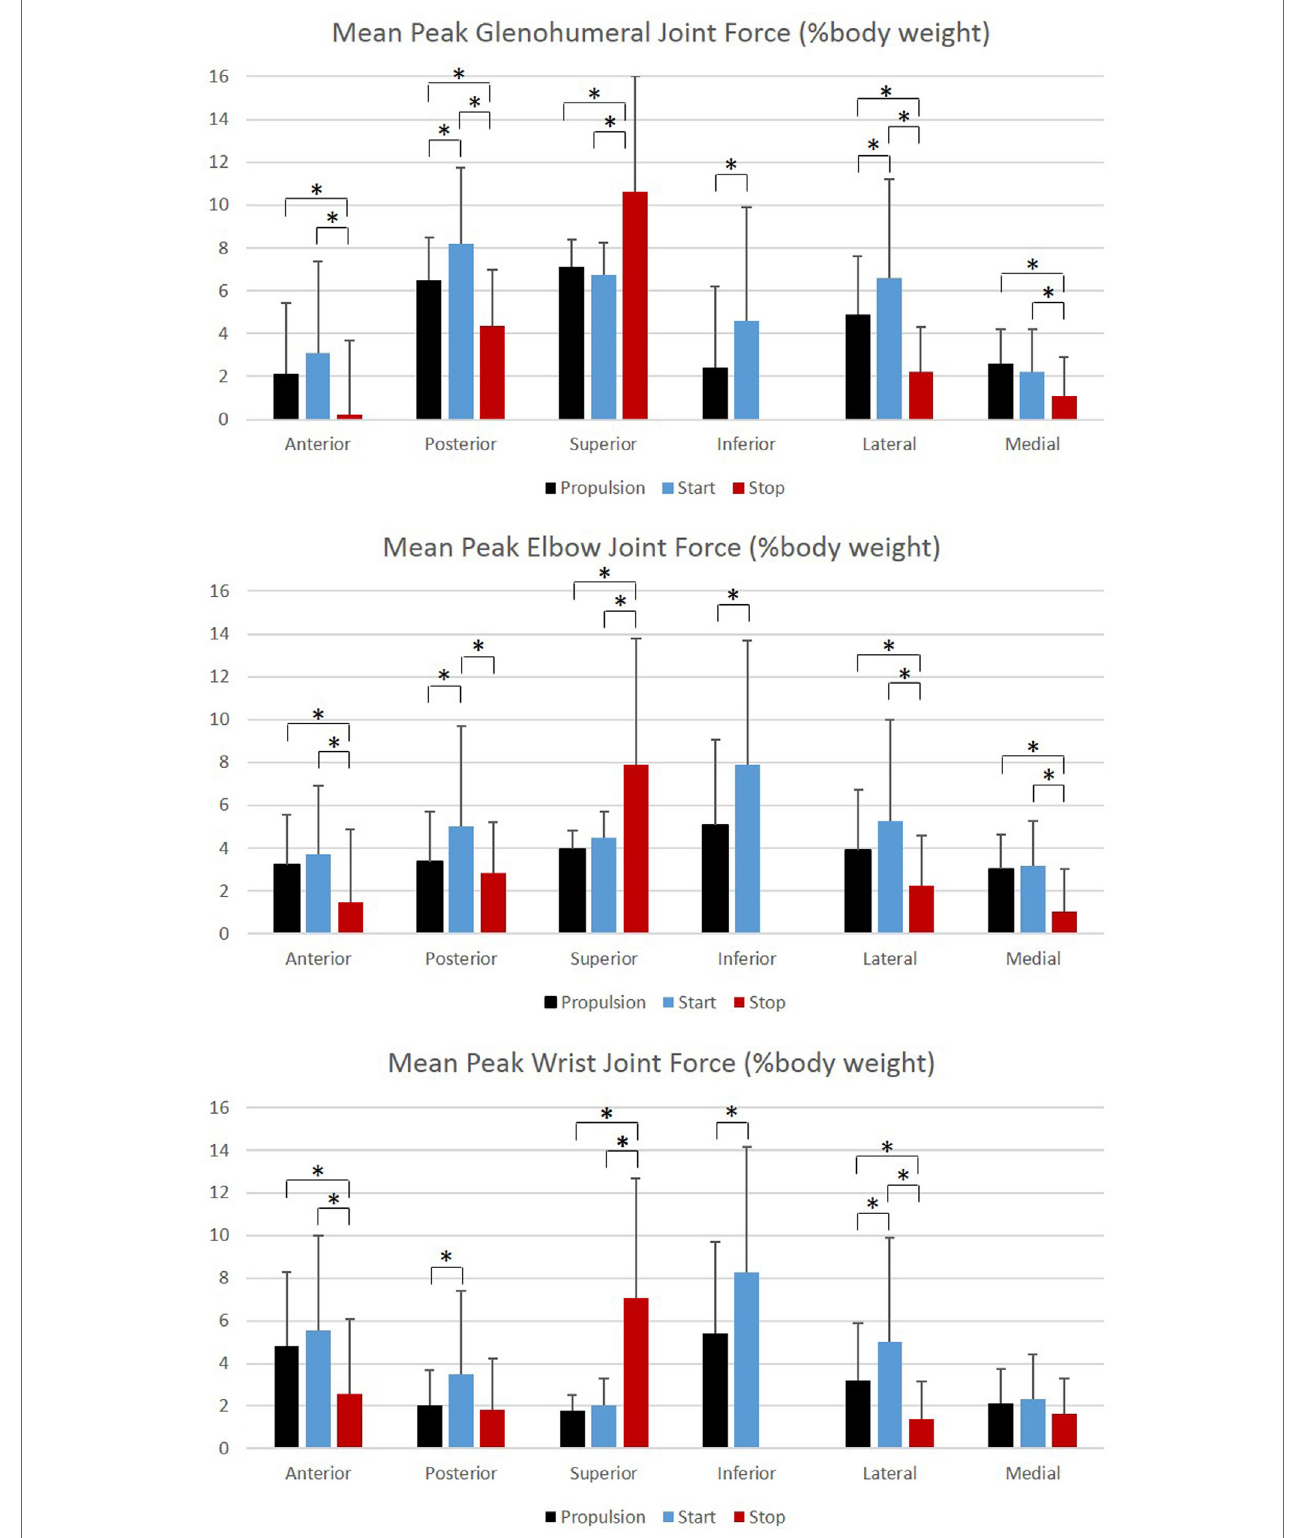
FigUre 10 | group mean peak joint forces (% BW) for the glenohumeral, elbow, and wrist joints during each functional mobility task, propulsion (black), start (blue), and stop (red) . One SD is represented by the thin vertical bar. Tasks connected by an asterisk are statistically significantly different ( p <